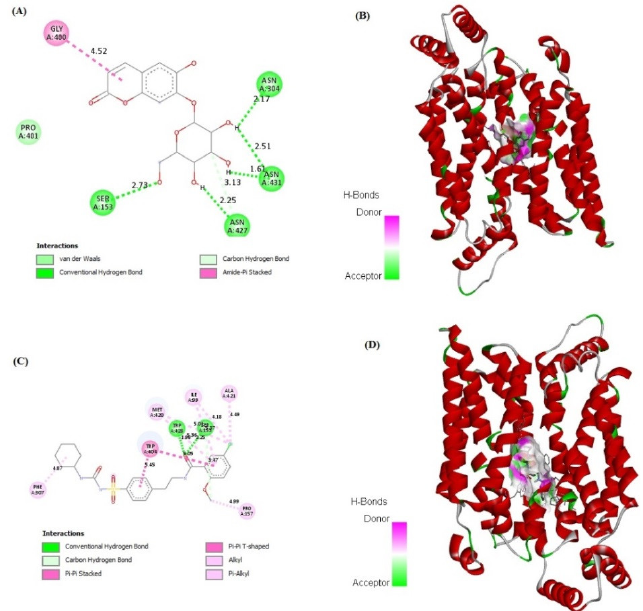
Figure 5. In silico analysis showing docking, amino acid binding interactions and binding pocket of ligand–receptor interactions of cichoriin ( A , B ) and GB ( C , D ) with AMPK. Glibenclamide (GB); AMP-activated protein kinase (AMPK).